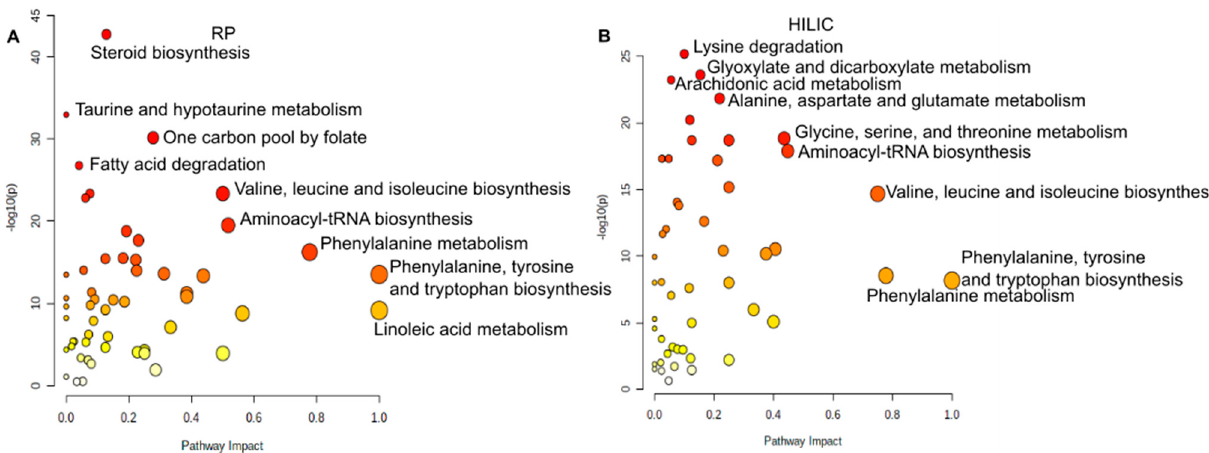
Figure 3. Pathway analysis chart of significantly different metabolites between WET PREP and swab: for RP ( A ) and HILIC ( B ). Metabolites that are significantly different between WET PREP and swab across each column type and with KEGG ID’s, as determined by MassTRIX annotation, were run against the human KEGG database by MetaboAnalyst. The top 20 pathways are shown according p -value and impact factor for out of degree centrality shown.